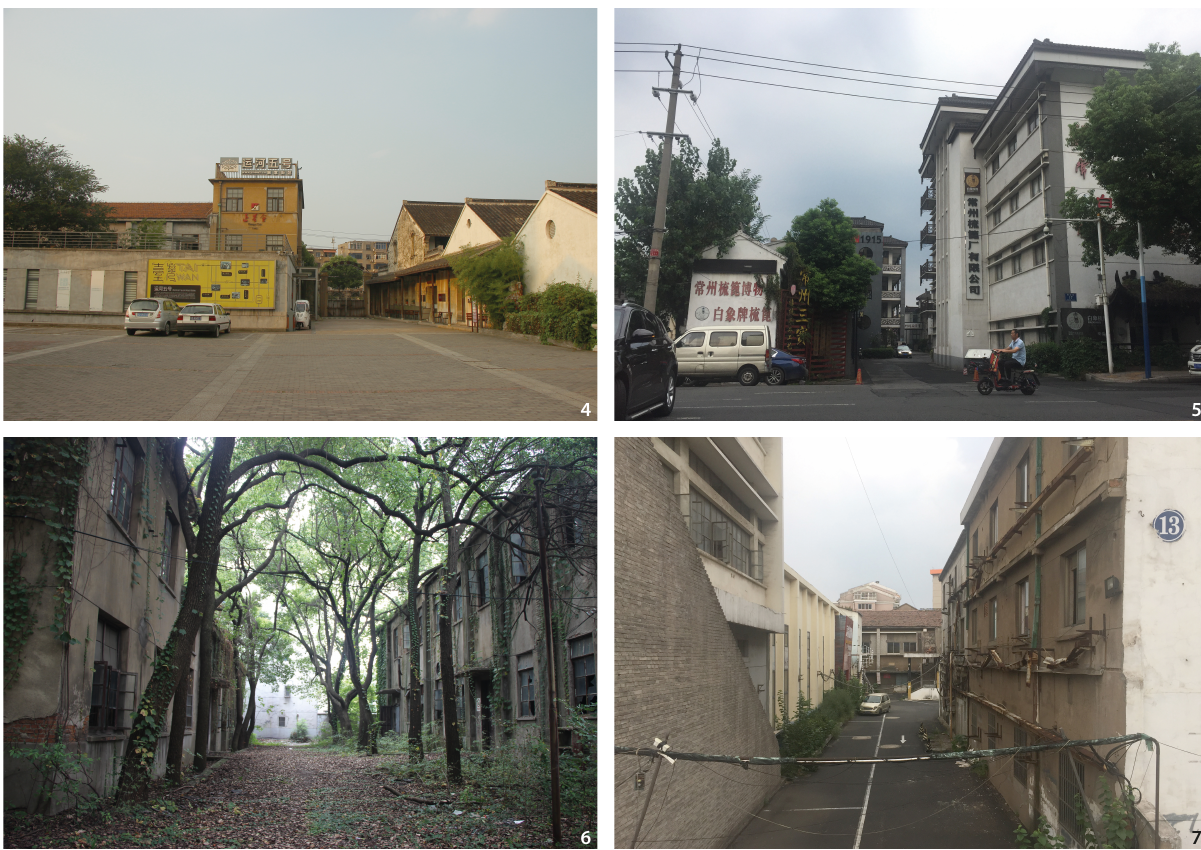
Figure 4 The Fifth Woolen Mill (Canal No. 5) (Source: the author). Figure 5 The Comb Factory Museum (Source: the author). Figure 6 Nautical Tnstrument Factory (Source: the author). Figure 7 Qingye Plastic Factory (Source: the